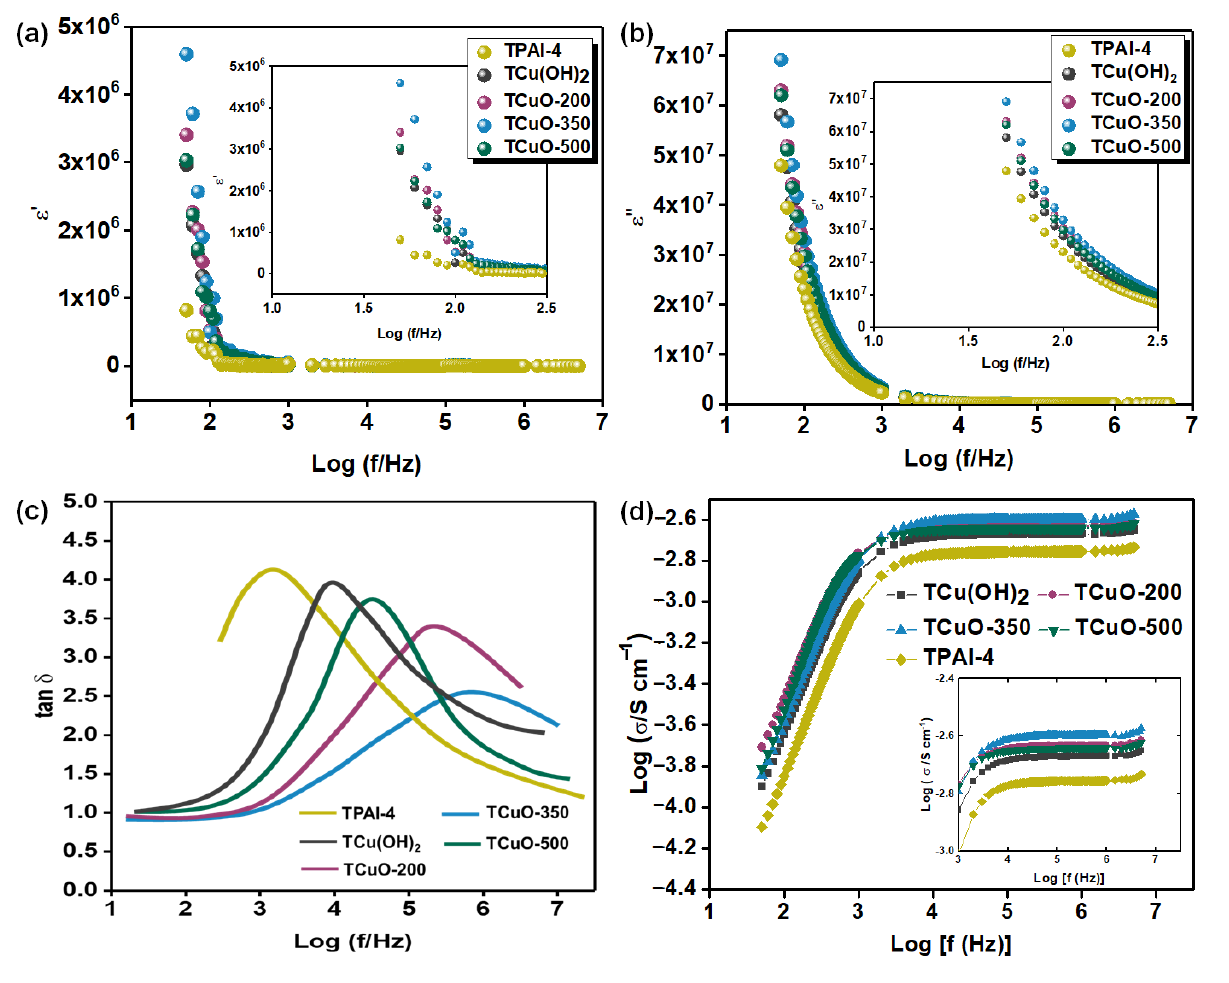
Figure 6. ( a ) Dielectric constants, ( b ) trends of dielectric loss, ( c ) variation of tangent loss, and ( d ) trend of AC conductivity as a function of logarithm frequency for all developed PCGE samples.